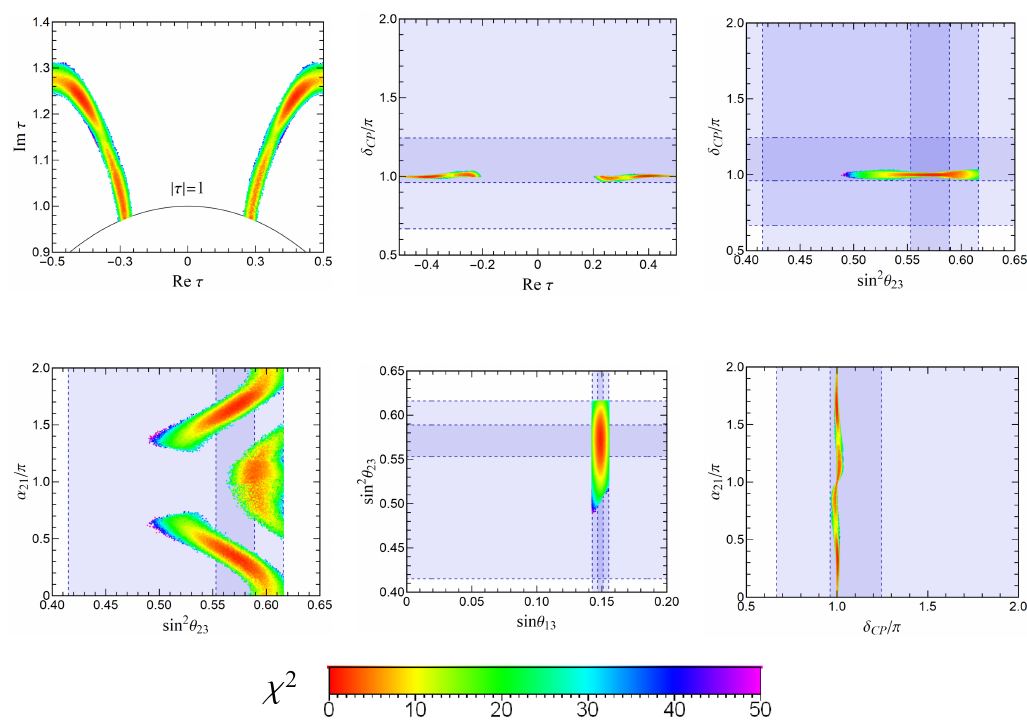
Figure 3 . The correlations between the neutrino parameters predicted in the example model of type V. The same convention as figure 1 is adopted